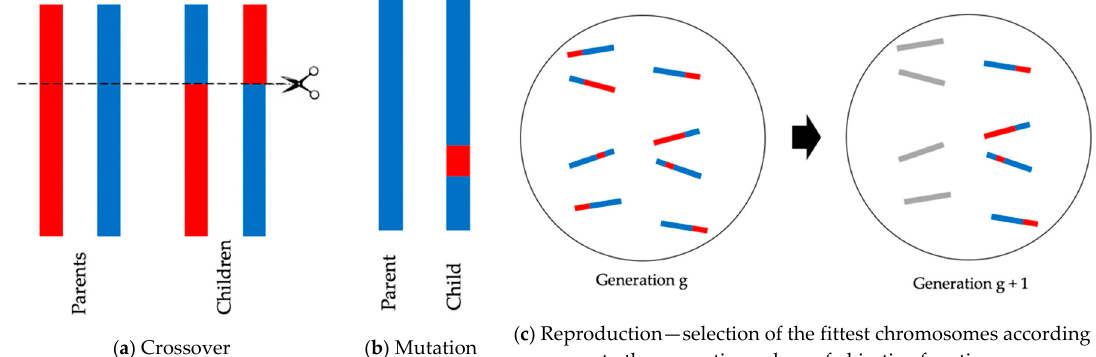
Figure 4. Genetic operations carried out on the chromosomes (see [16]).